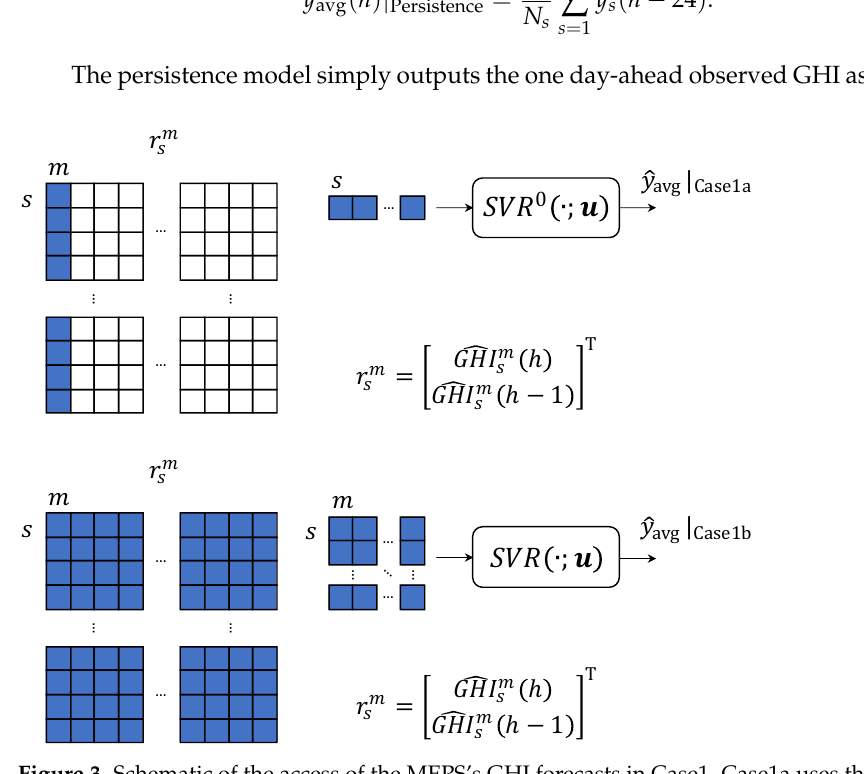
Figure 3. Schematic of the access of the MEPS’s GHI forecasts in Case1. Case1a uses the MSM’s GHI ( m = 0) only, and Case1b uses MEPS all member ( m = 0,1, . . . ,20). They directly predict regional GHI with one SVR